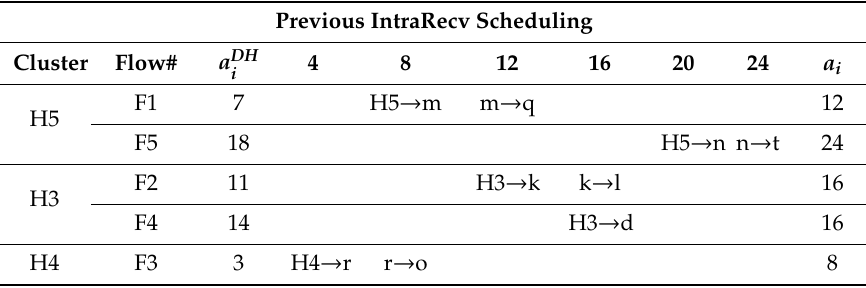
Table 3. Results of previous scheme IntraRecv scheduling of Figure